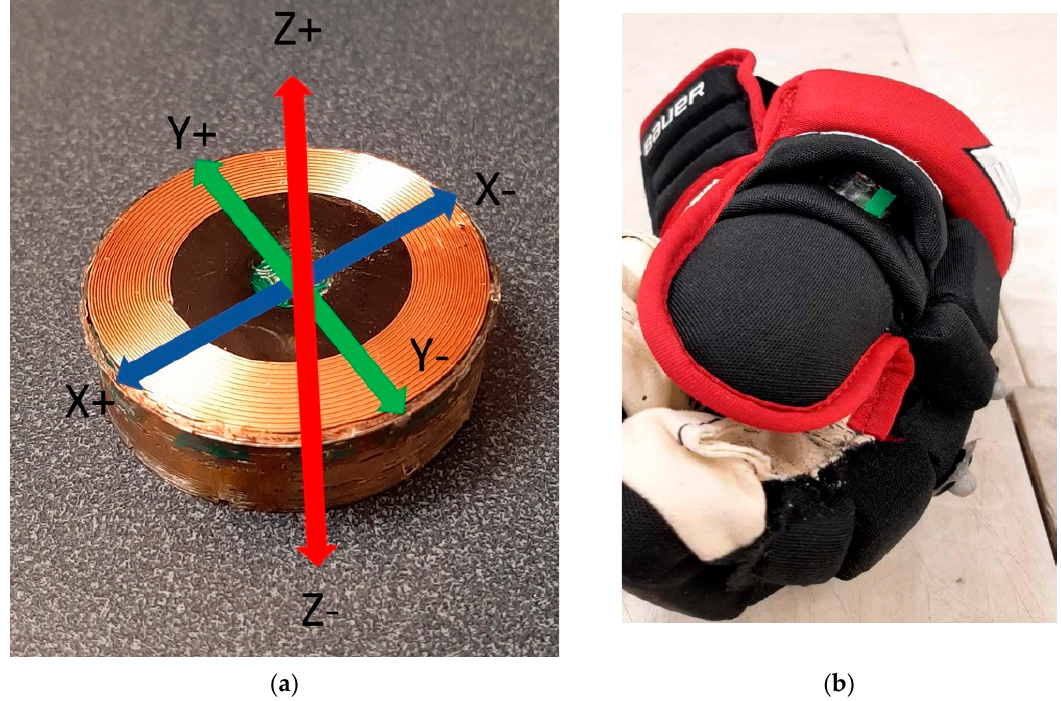
Figure 3. IMU axis alignment: ( a ) the +Z axis was orthogonal to the top surface of the IMU puck; and ( b ) the +Z was systematically aligned in the “thumbs up” direction of the glove; however, the direction of X and Y was not consistently maintained across testing.